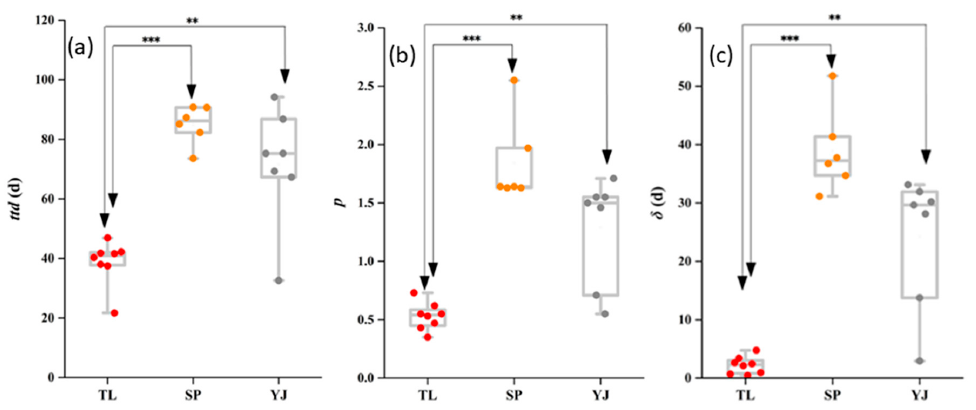
Figure 4. Comparison of survival parameters ttd ( a ), p ( b ), and δ ( c ) of E. coli O157:H7 in soils from di ff erent sampling sites. TL, SP, and YJ indicate that the soil samples were collected from Tongliao, Siping, and Yanji, respectively. *, **, and *** indicate statistical significance at 0.05, 0.01, and 0.001